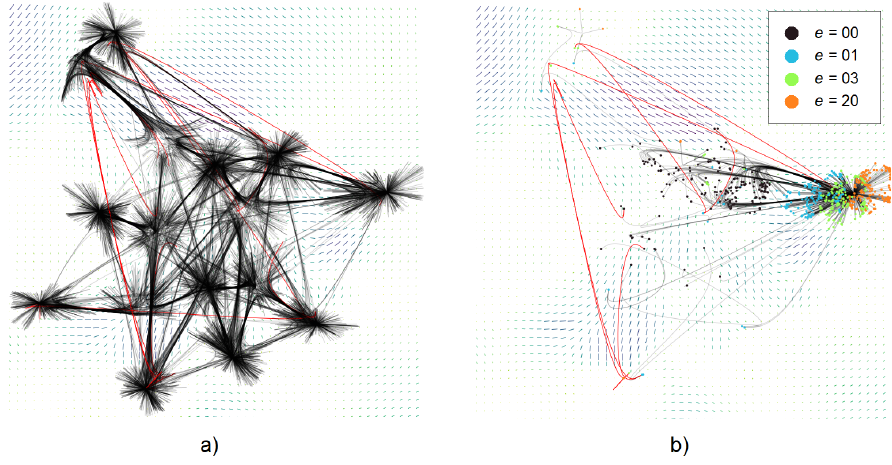
Figure 6. When visualizing trajectories, it is possible to highlight the ones that attained high error values when approximating the vector field, in search of outliers. ( a ) shows trajectories with the error above a certain threshold (0.1) highlighted in red, while all others are shown in black; ( b ) filters the projection to only instances corresponding to label “7”, which seem to contain a few outliers. Data points were plotted again and colored according to which feature set they were taken from, so trajectory direction can be better understood. In this case, the highlighted trajectories move through long distances, at times in the exact opposite way of the vector field.